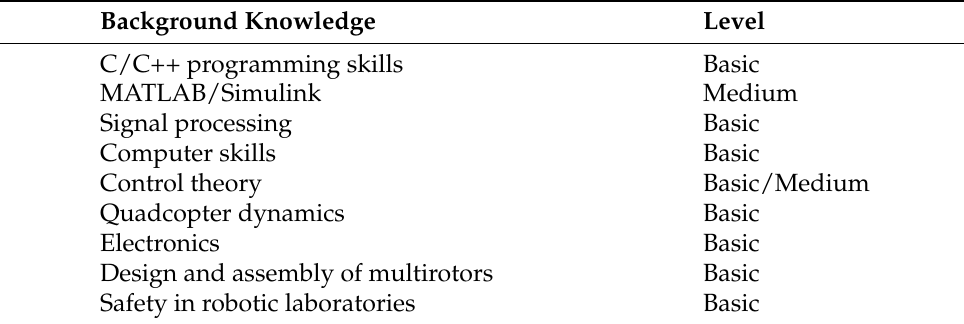
Table 1. Desired background knowledge for